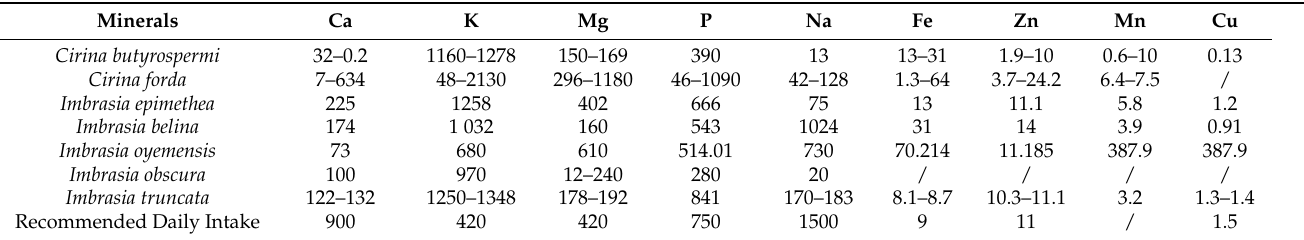
Table 6. Mineral composition (mg/100 g dry matter basis) of caterpillars consumed in